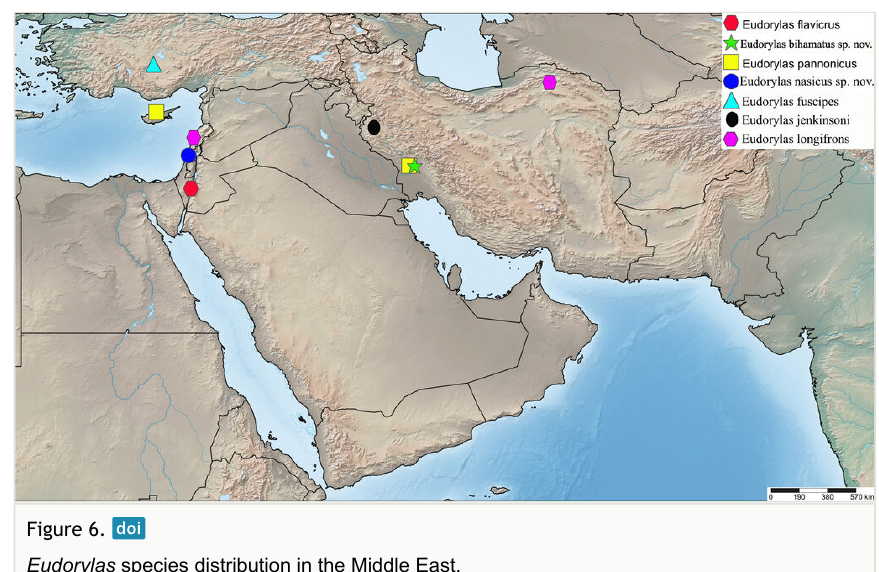
Eudorylas species distribution in the Middle